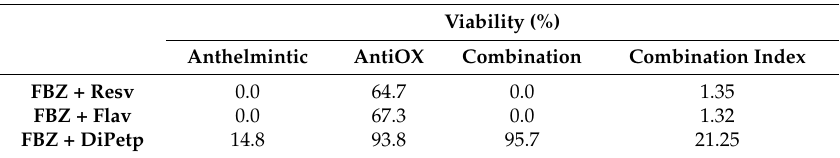
Table 7. Viability (%) of NTS following exposure to FBZ, antioxidant alone and the combination, and the cooperative index for each